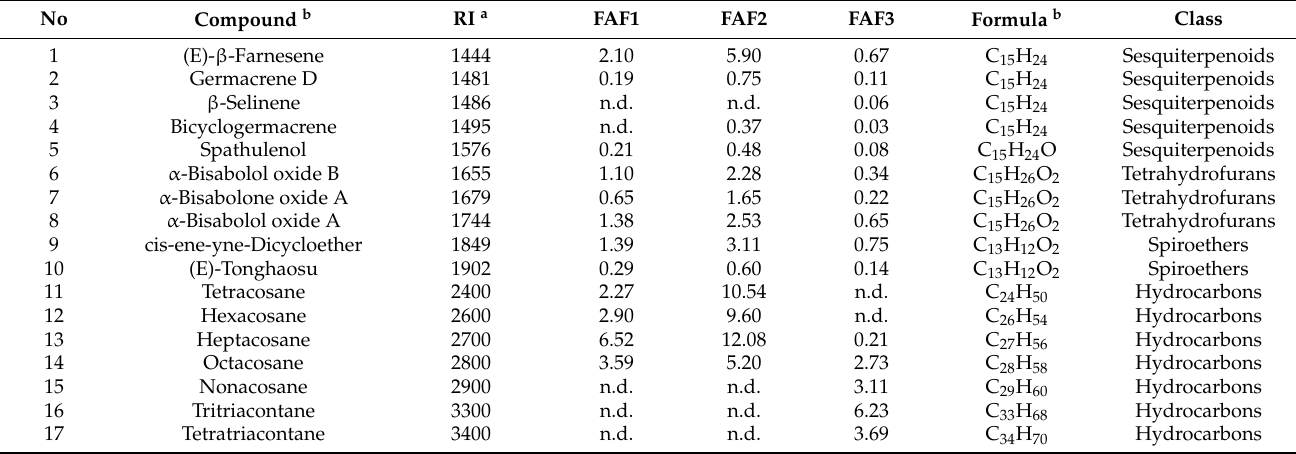
Figure 3. Total ion current chromatogram (TIC) of main volatile compounds in Matricaria recutita white ray floret supercritical fluid extracts. The numbers above the peaks represent the main identified compounds in Table 4. Table 4. Chemical composition (%) of the cyclohexane extracts from Matricaria recutita white ray floret supercritical fluid